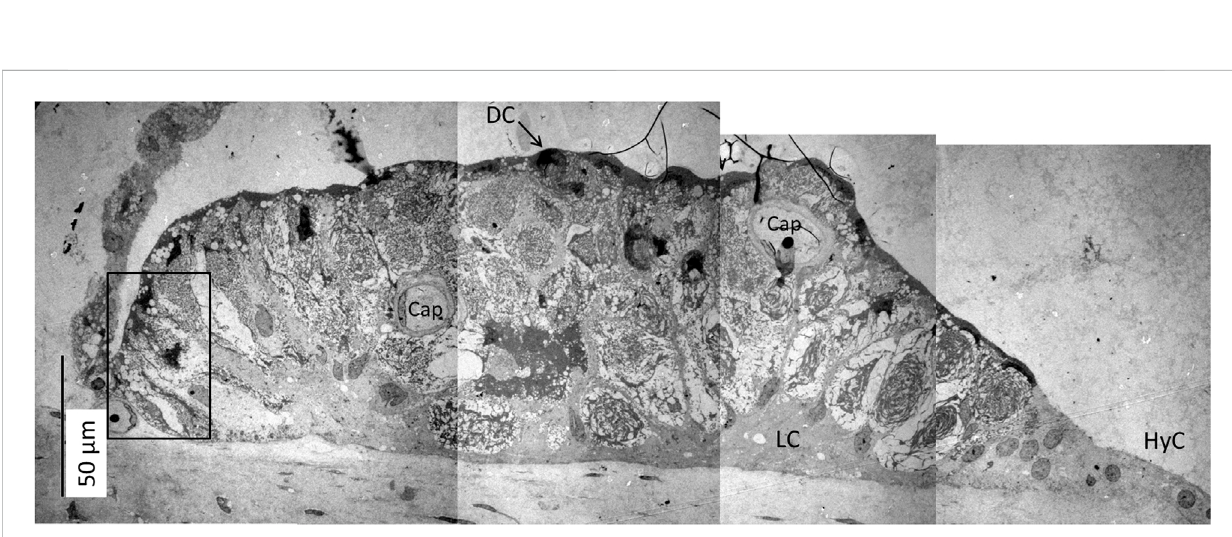
FIGURE 3 Electron micrograph of a crocodilian stria vascularis showing apical dark (DC) and basally light cells (LC). The epithelium contains capillaries (Cap). The LCs form a network with intercellular spaces containing DC enfoldings. The DCs contain clear secretory-like vesicles near the endolymph lumen. Framed area shows a DC extending basally and is magni fi ed in Figure 13. HyC, hyaline cells; RM, Reissner